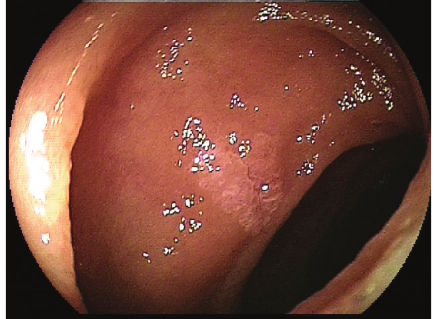
Figure 9: Flat adenoma of the